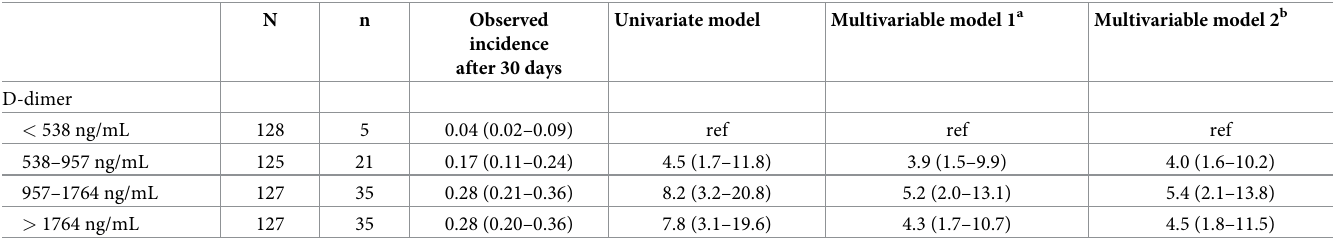
Table 2. Association between D-dimer values and in-hospital mortality. N